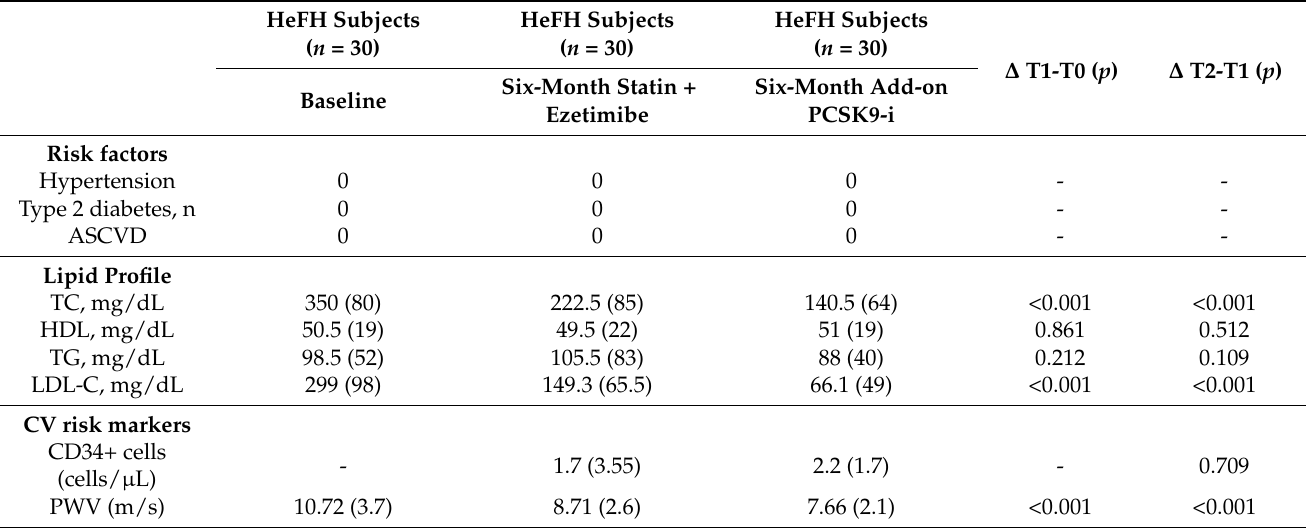
Table 2. Main HeFH subject characteristics over time points.